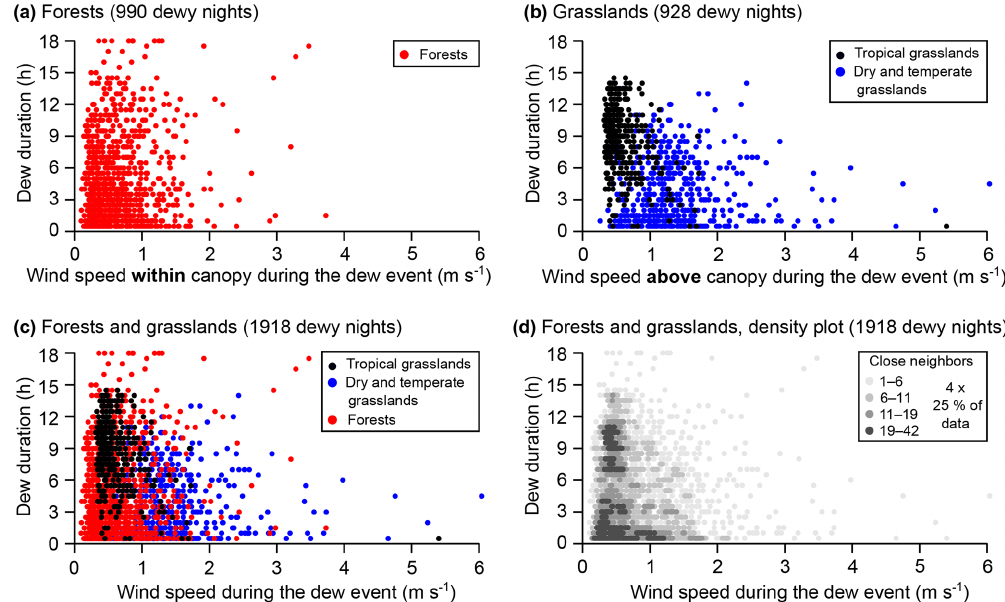
Figure 8. Dew duration versus wind speed averaged during a dew event for different groups (nightly timescale): forests ( a ; wind speed within canopy), grasslands ( b ; wind speed 1m above canopy), both of these (c) and density plot of both (d) . In the density plot, four colors indicate the number of neighbors around a data point in a small rectangle ( ∼ 2% of the figure). Each color represents 25% of the total number of